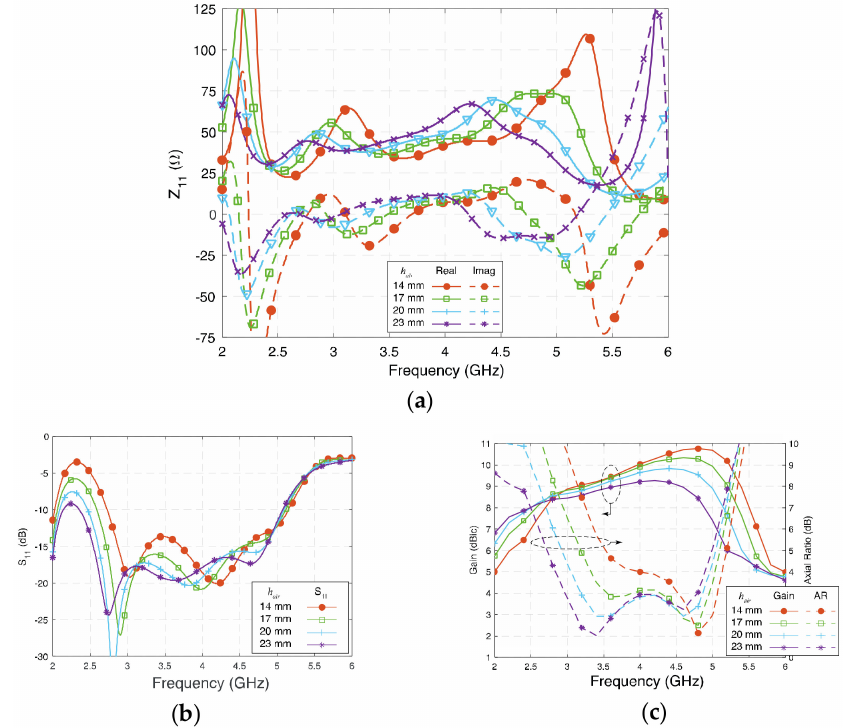
Figure 9. ( a ) Impedance (Z 11 ), ( b ) reflection coefficient (S 11 ), and ( c ) gain and axial ratio of the proposed antenna at different h air .